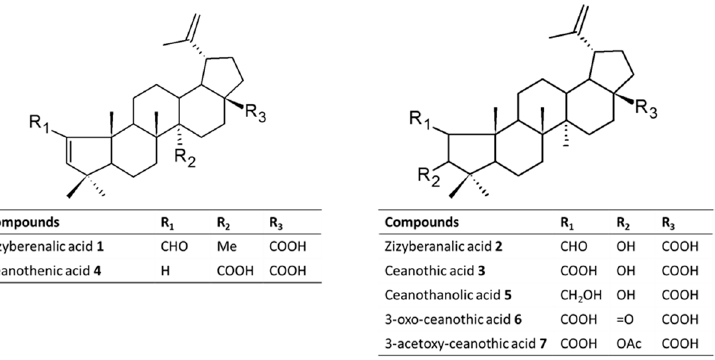
Figure 2. Chemical structures of Ceanothane triterpenes isolated from Chilean Rhamnaceae (com- pounds 1 – 5 ) and derivatives prepared ( 6 and 7 ).